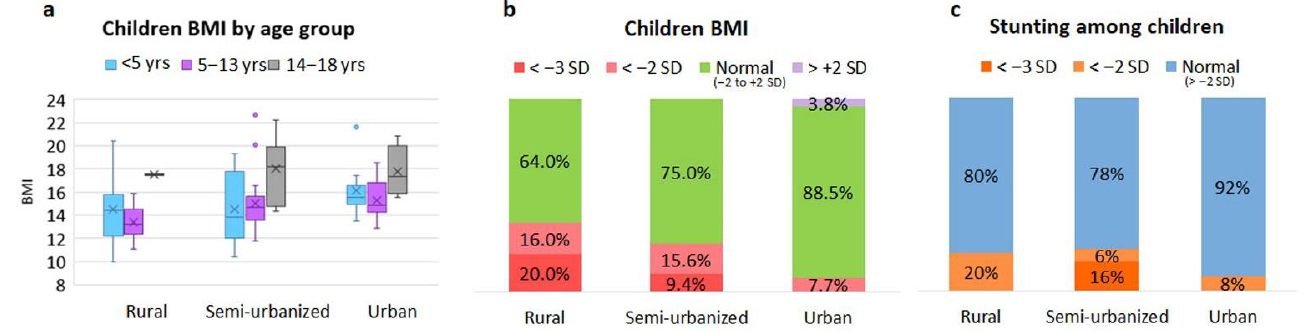
Figure 7. Comparison of BMI categories among children from the rural, semi-urban and urban ar- eas. ( a ) BMI by age group, boxplots show median and interquartile range (IQR). “x” is the mean and blue dots are outliers ( b ) BMI distribution. BMI < − 2 SD defines acute malnutrition; < − 3 SD severe acute malnutrition. For children < 5 years, SD of weight-for-height was considered instead of BMI. ( c ) Prevalence of stunting among children; < − 2 SD as moderate stunting, < − 3 SD as severe stunting. yrs, years old.